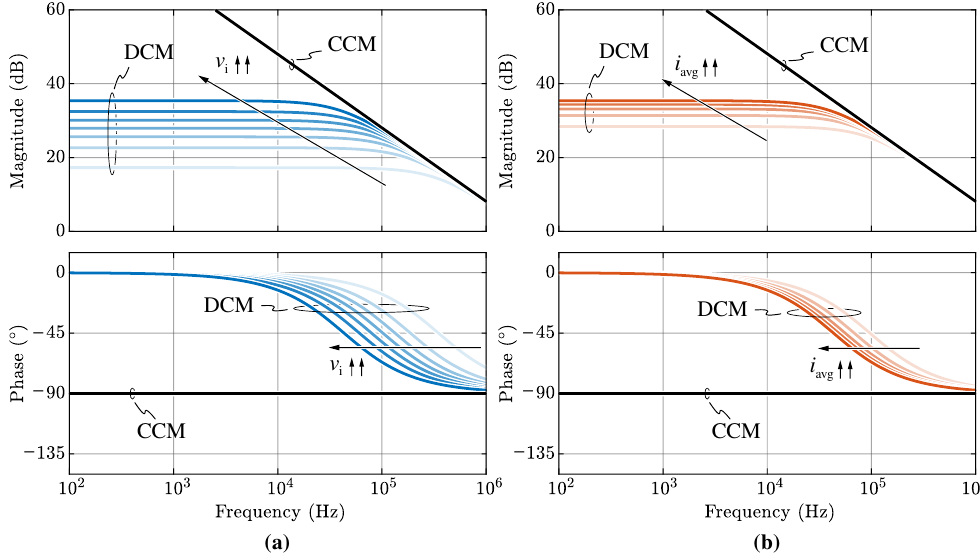
Figure 7. Duty-to-current transfer function dependence on ( a ) the input voltage v i = 25, 75, . . . ,325V (with i avg = 10A) and ( b ) the average inductor current i avg = 2, 4, . . . ,10A (with v i = 325V), considering L i = 25µH, f sw = 100kHz and v dc = 400V.